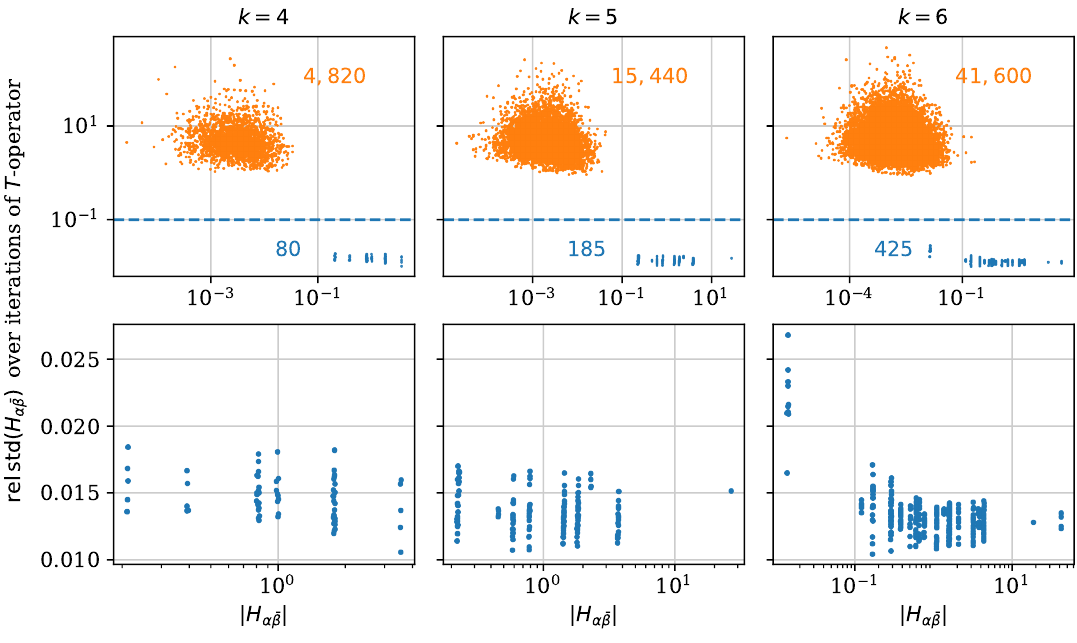
Figure 10 . Clustering of elements in H for ψ = 10 . ( Top row ): orange clusters correspond to vanishing elements, blue clusters correspond to non-vanishing values. ( Bottom row ): close- up view of the blue clusters. The number of vertical lines is in close relation to the number of equivariant